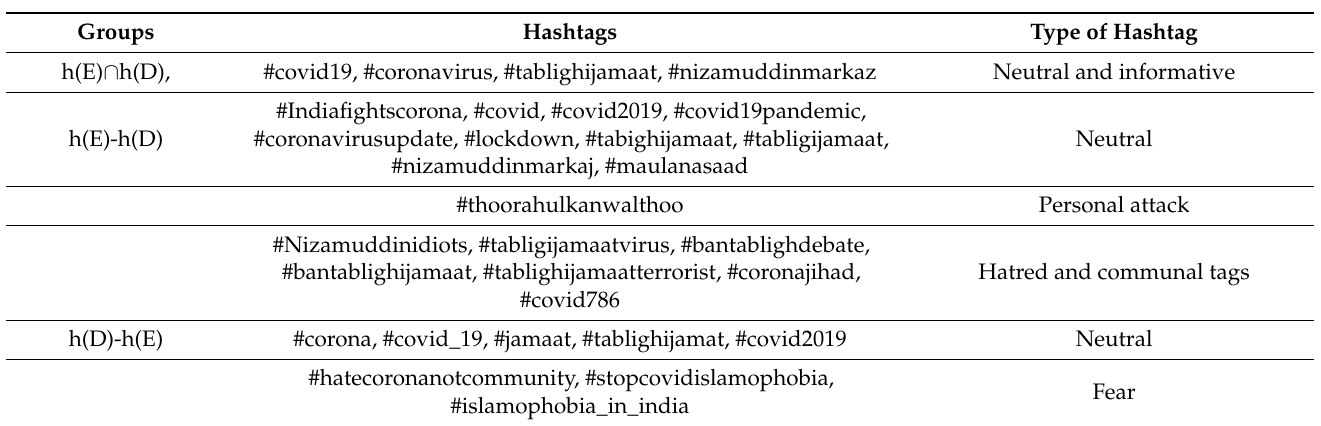
Table 4. Example of hashtags used by E and D